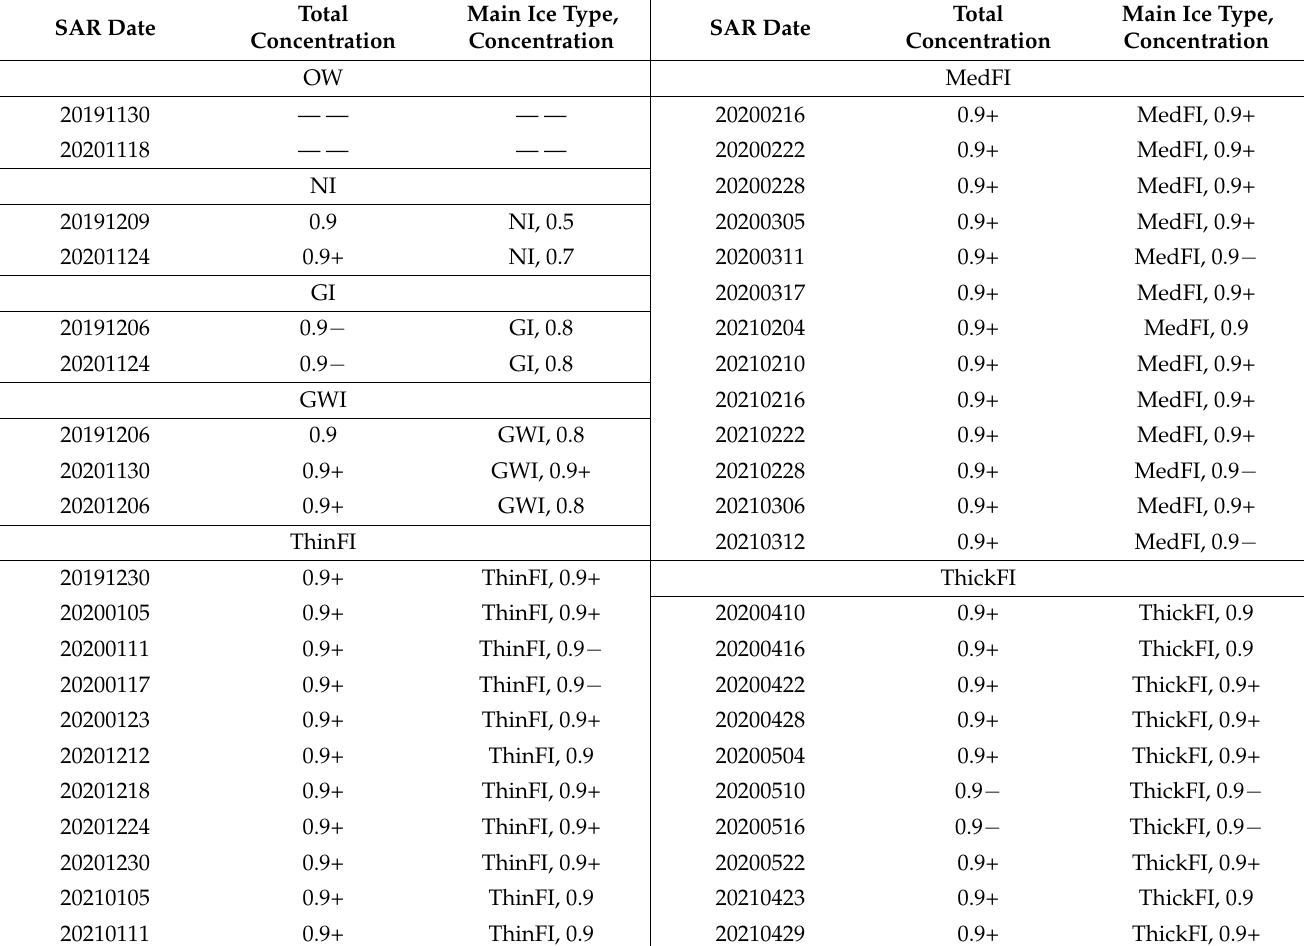
Table 4. Ice concentration information of the selected SAR scenes that meet the sampling